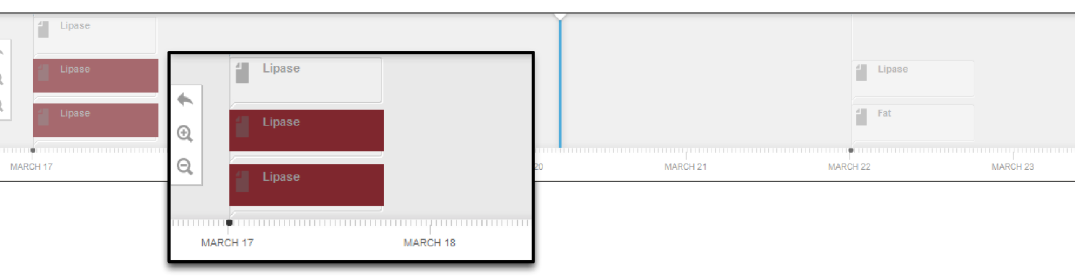
Figure 9. Micro-contribution